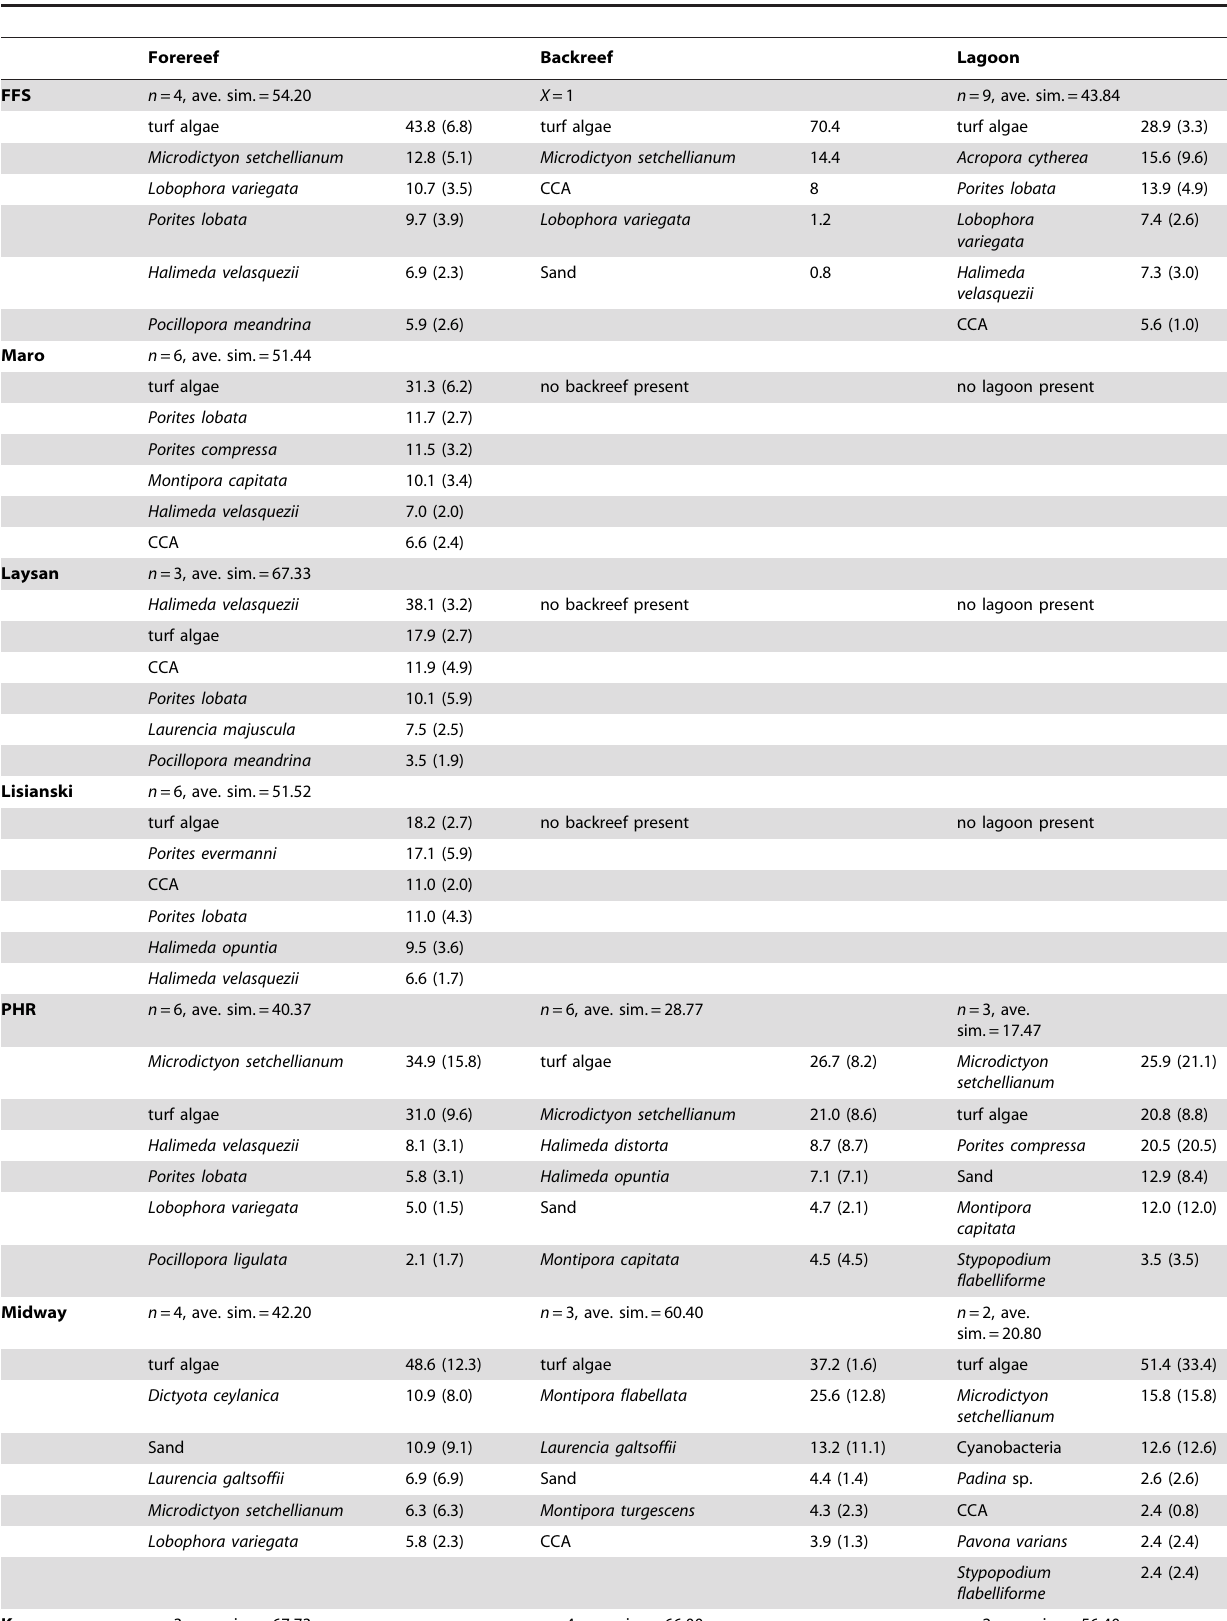
Table 2. Average percent cover of the six most dominant items occurring at each island by habitat type.